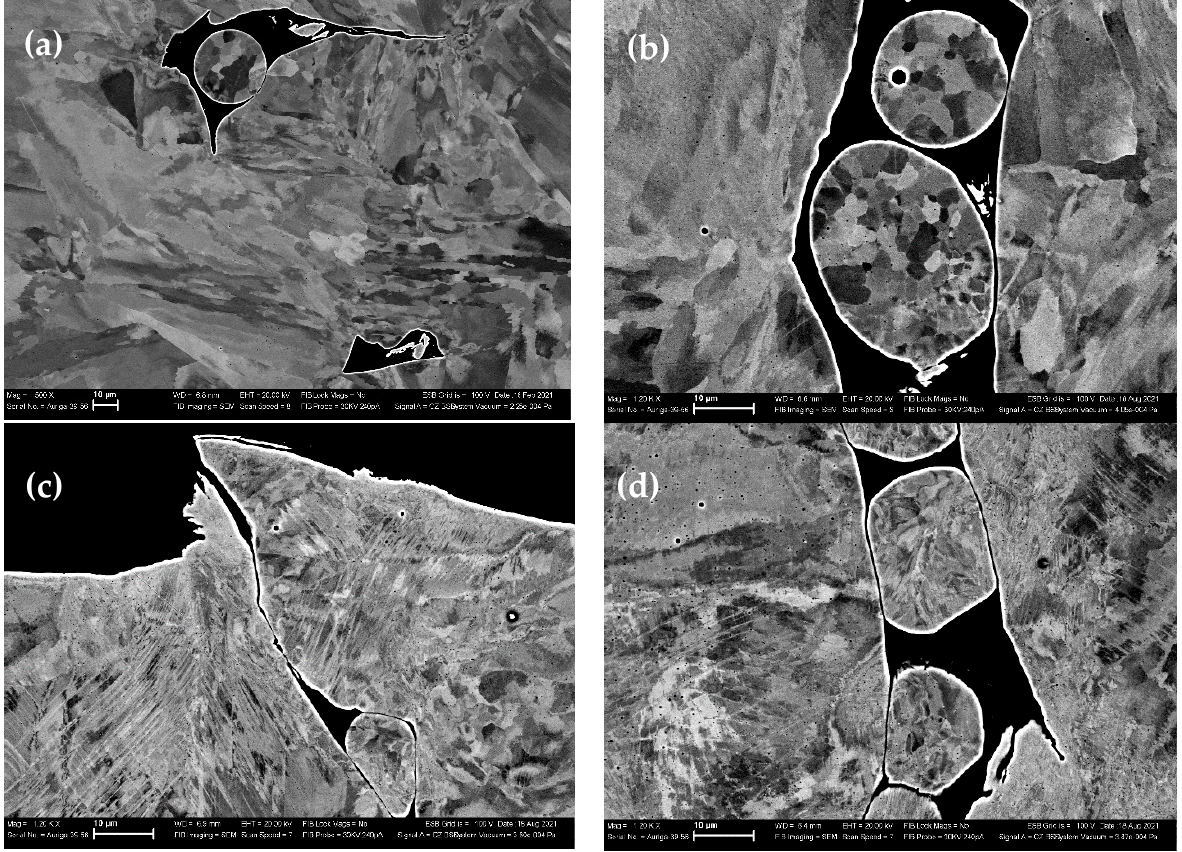
Figure 3. Porosity in the studied samples: ( a ) as-built; ( b ) 8 × 10 − 4 s − 1 , ( c ) 3 × 10 − 3 s − 1 , and ( d ) 2 × 10 − 2 s − 1 .